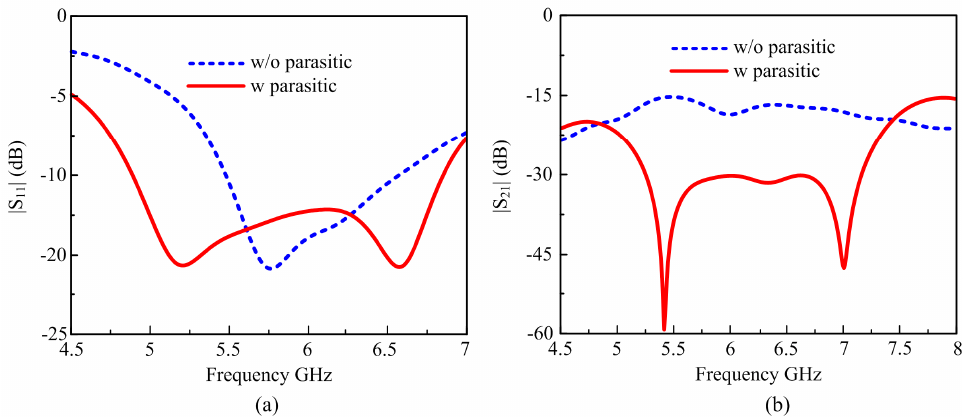
Figure 3. ( a ) Simulted|S 11 | without and with parasitic elements. ( b ) simulated |S 21 | without and with parasitic elements. with parasitic